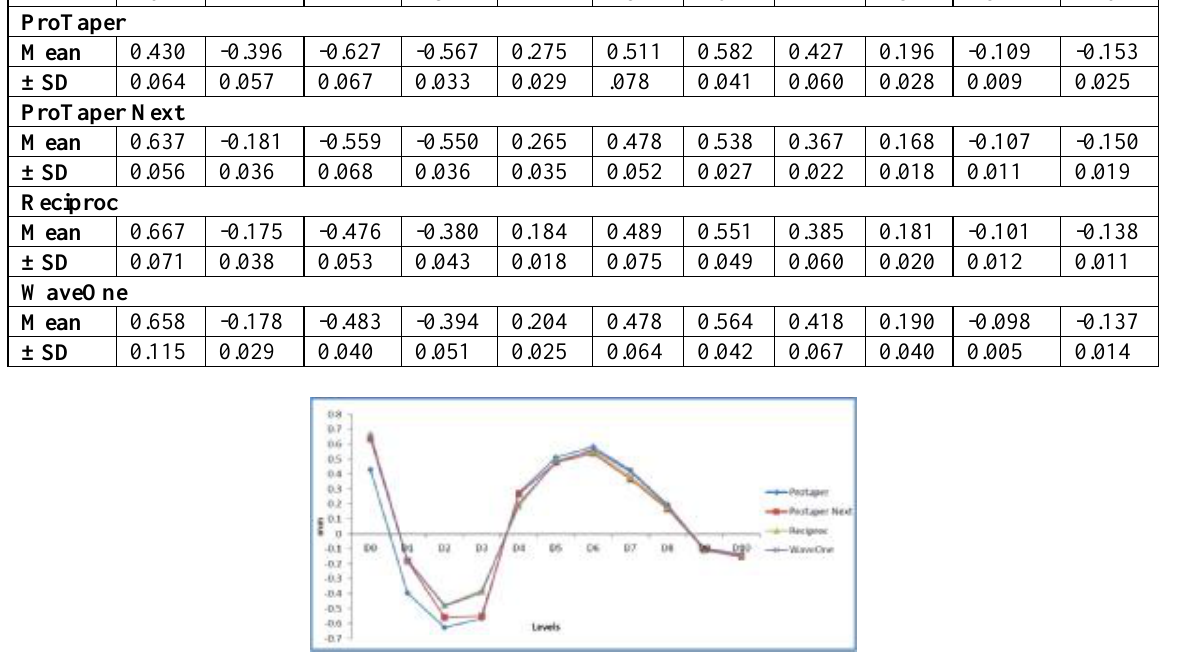
Figure 5: Line Chart of Centering